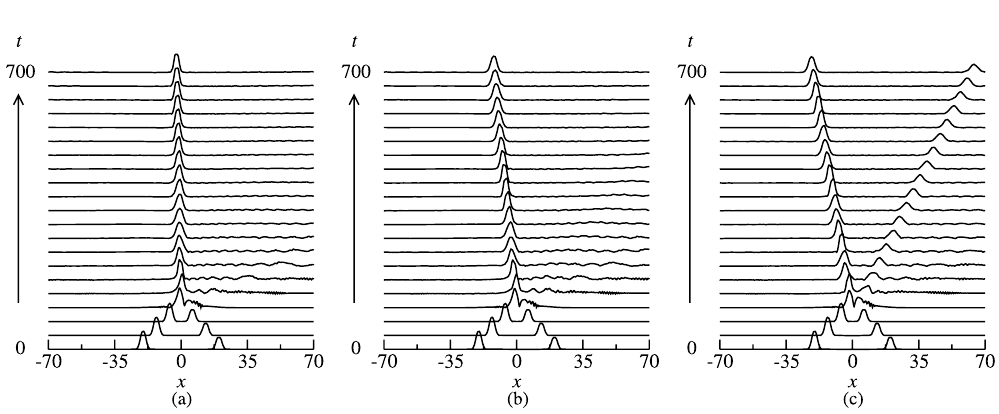
Figure 12. The effect of initial phase difference on the outcomes of collisions that lead to merger of solitons into a quiescent one as a result of in-phase collisions. The parameters are κ = 10, δ = 0.2, Ω = − 10.15, m = 0.5, c = 0.2. ( a ) Δ θ = 1°, ( b ) Δ θ = 6°, and ( c ) Δ θ = 20°. Only | u | is shown.